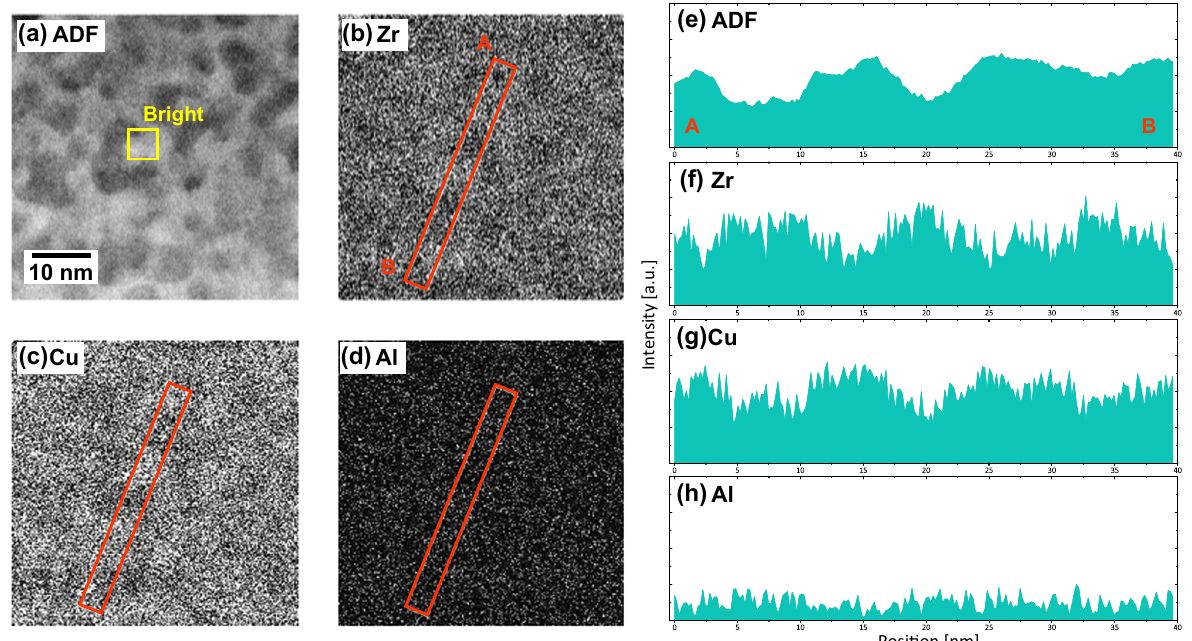
Fig. 7 EDS mapping analyses of the pHPQ sample. a ADF-STEM image of the pHPQ sample synthesized at 5.5 GPa and 880 K. Mapping of b Zr, c Cu, and d Al in the same area as a . Composition in yellow square in a is ~33 at.% Zr, 59 at.% Cu, and 8 at.% Al in the bright area. Line pro fi les of e ADF, f Zr, g Cu, and h Al in the red A – B area.